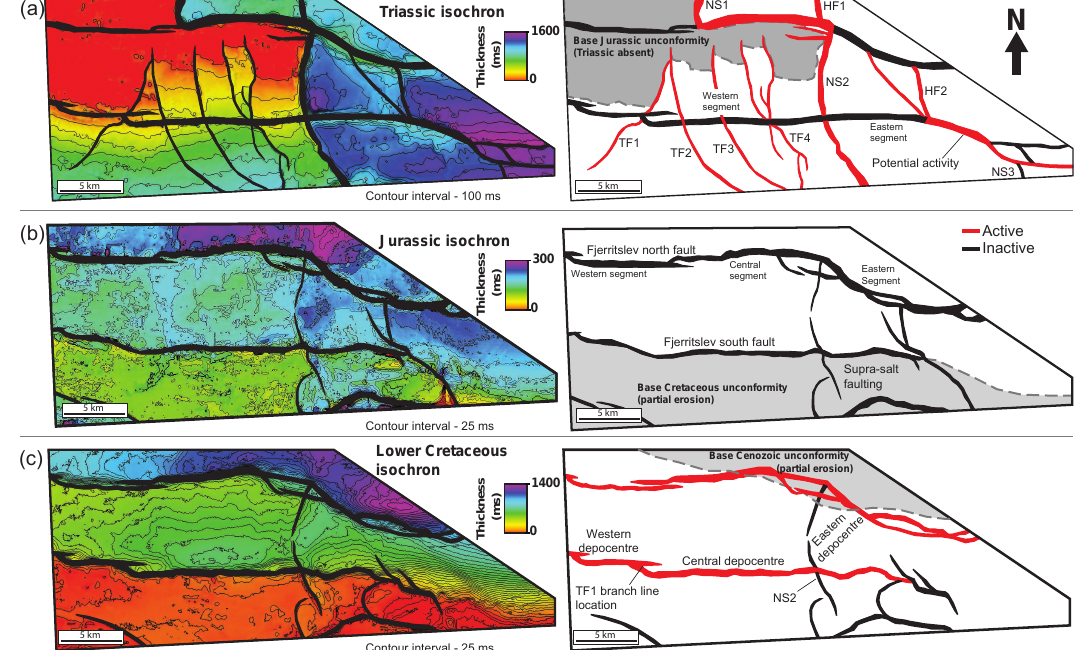
Figure 6. (a) Isochron showing thickness of the Triassic interval and the associated faults active during this interval based on sediment thickness changes and depocentres. (b) Isochron of Jurassic strata showing thickness and the faults that appear to have been active during this interval. (c) Isochron of Lower Cretaceous strata showing the faults that appeared to be active during this